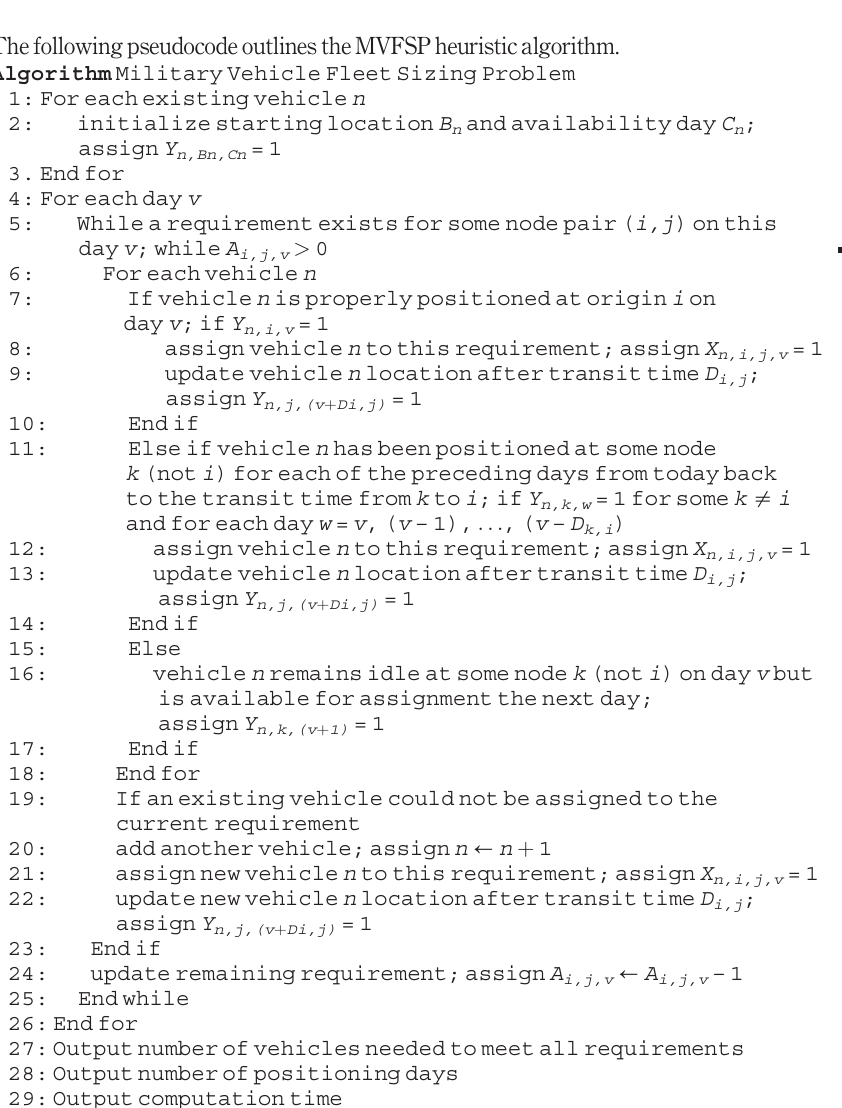
Algorithm Military Vehicle Fleet Sizing Problem 1: For each existing vehicle